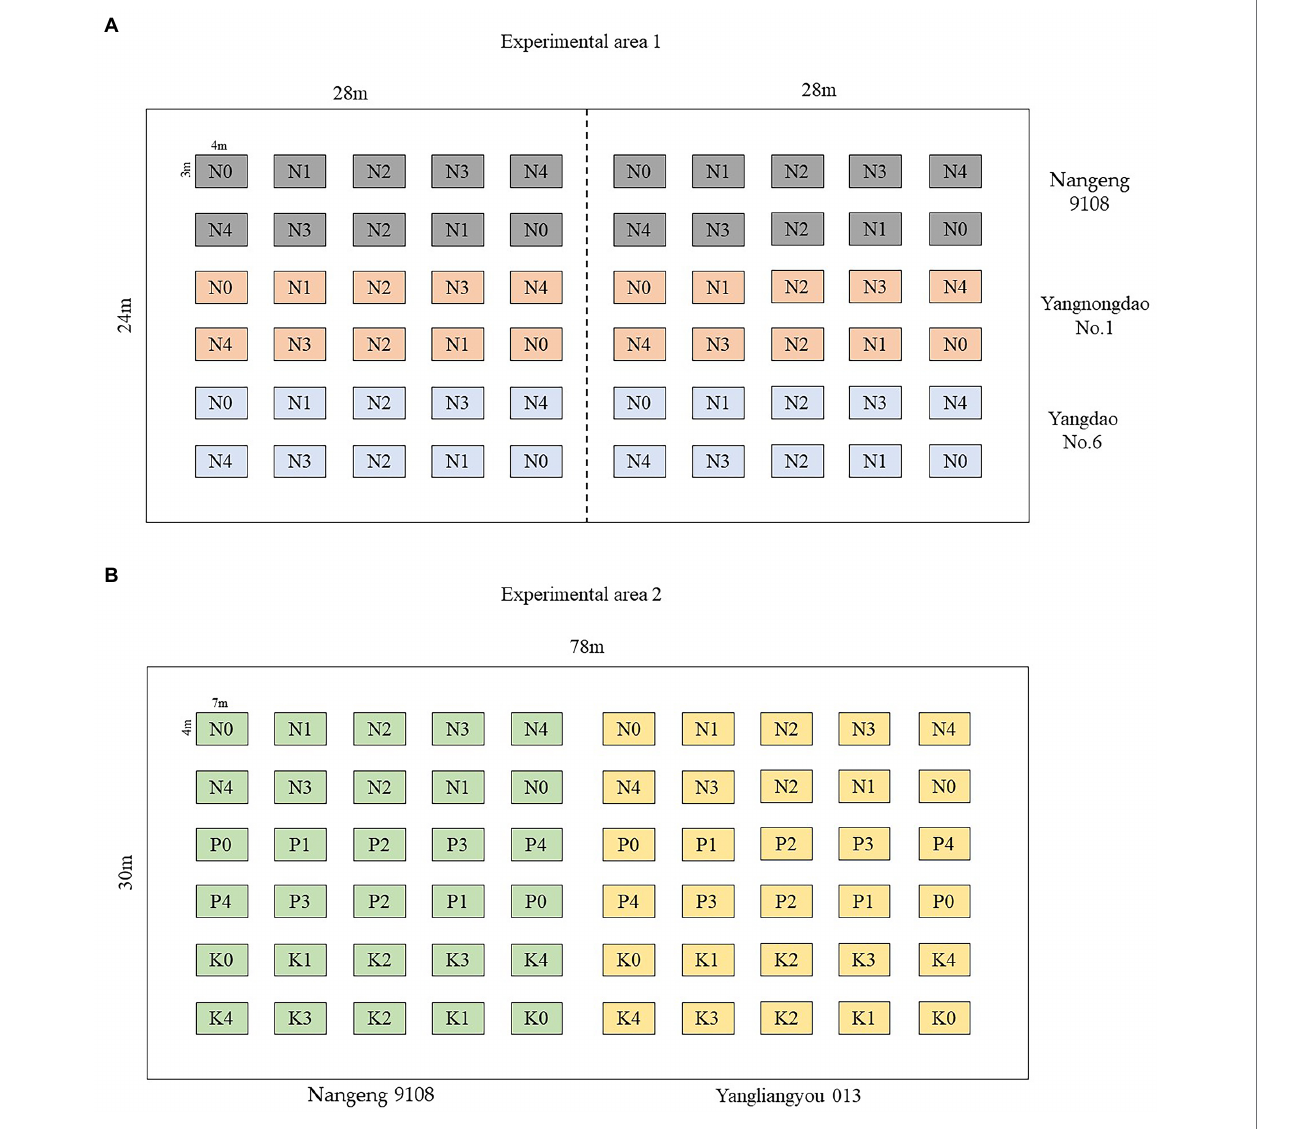
FIGURE 3 | Experimental plot distribution map. (A) Experimental area 1, (B) Experimental area